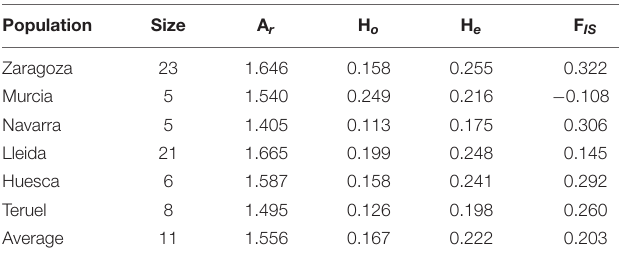
calculated by DiveRsity